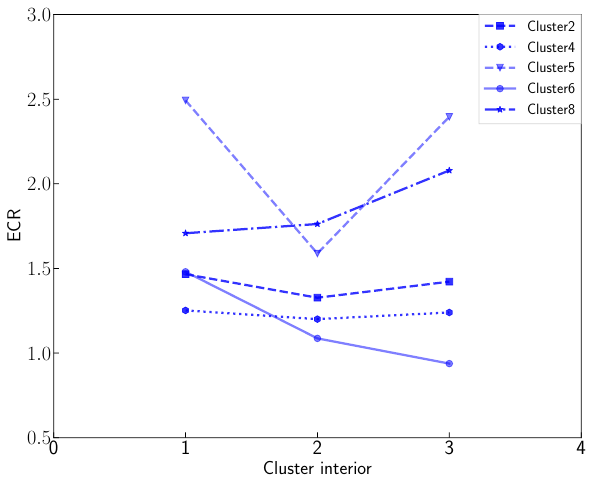
Figure 14. ECR values near the centroid of different